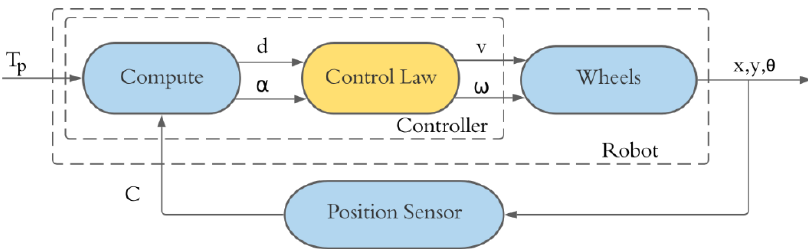
Figure 3. Diagram of the position control problem of a control algorithm [4].